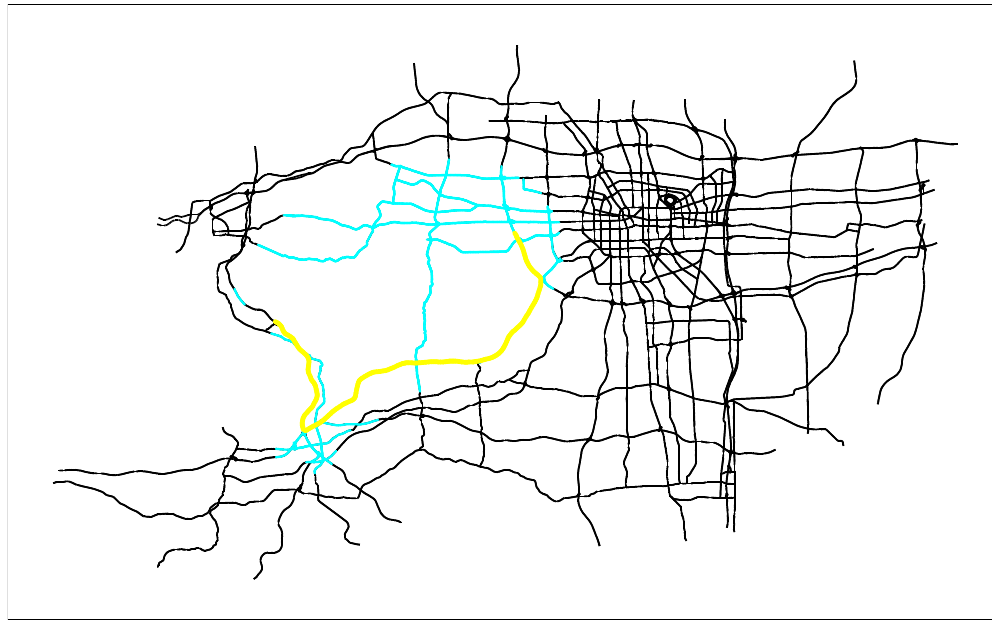
Figure 8. The search results of the shortest path algorithm based on the dynamic ellipse limit search area of the virtual boundary under the 85% confidence level.